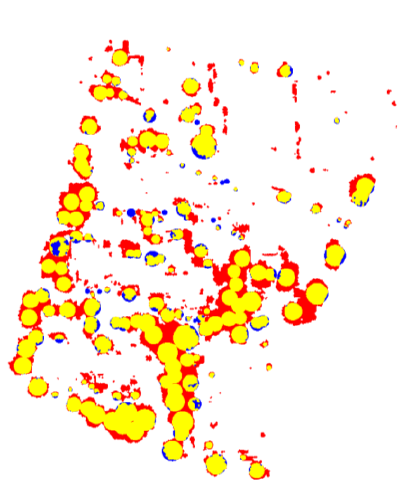
Figure 10. Buildings classification (correctly classified as yellow, misclassified as red, missing as blue) .